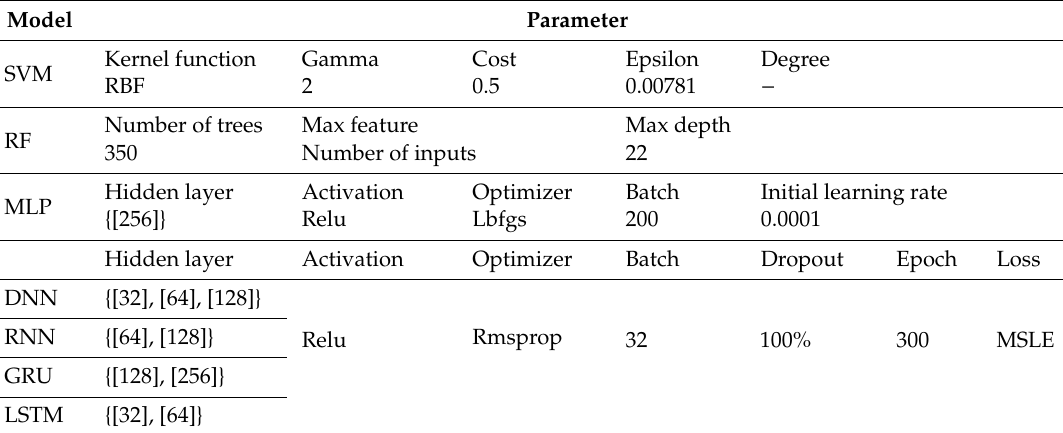
Table 6. Optimal parameters of models determined by the grid research